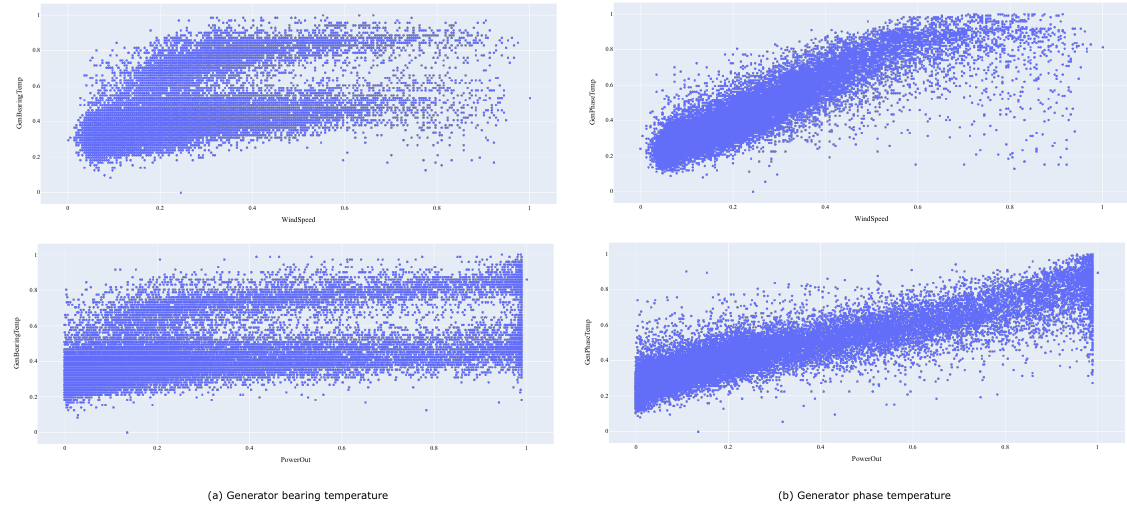
Figure 3. Relationship between component temperature and operating